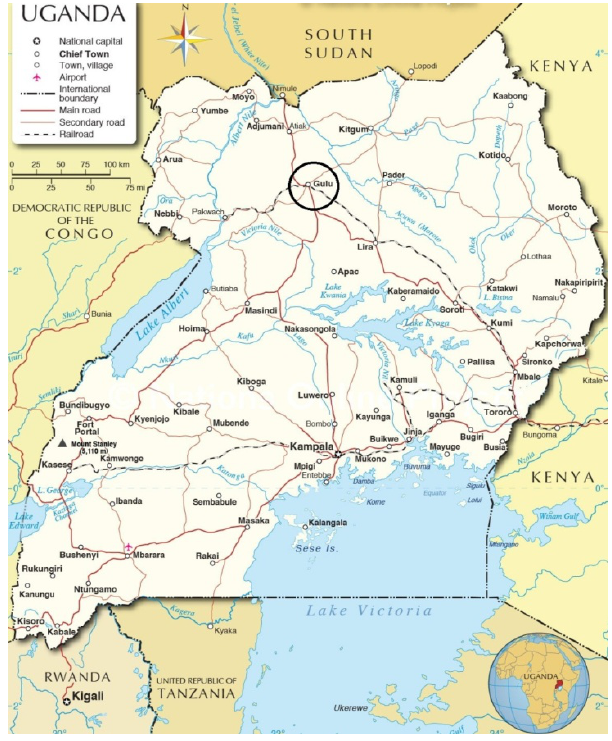
Figure 3. Map of Uganda showing the location of study area, in circle (based on United Nations (UN) map, Source: UN Cartographic section [36]). Reprinted/Reproduced with permission from UN Online Project,